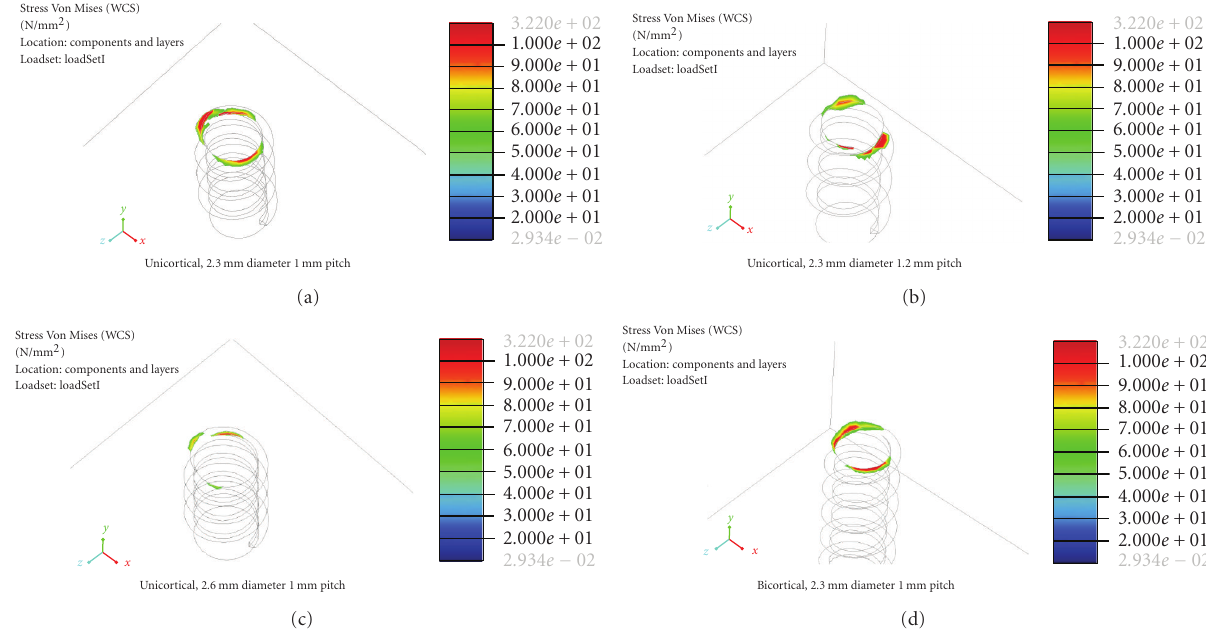
Figure 9: An isometric plot of the von Mises stress in bone surrounding the 4 configurations of screw implants. The plot shows only stresses above a 60 MPa threshold. Table 6: Peak von Mises stress in the bone surrounding screw implants for the four di ff erent screw configurations. Fixation Major diameter (mm) Pitch